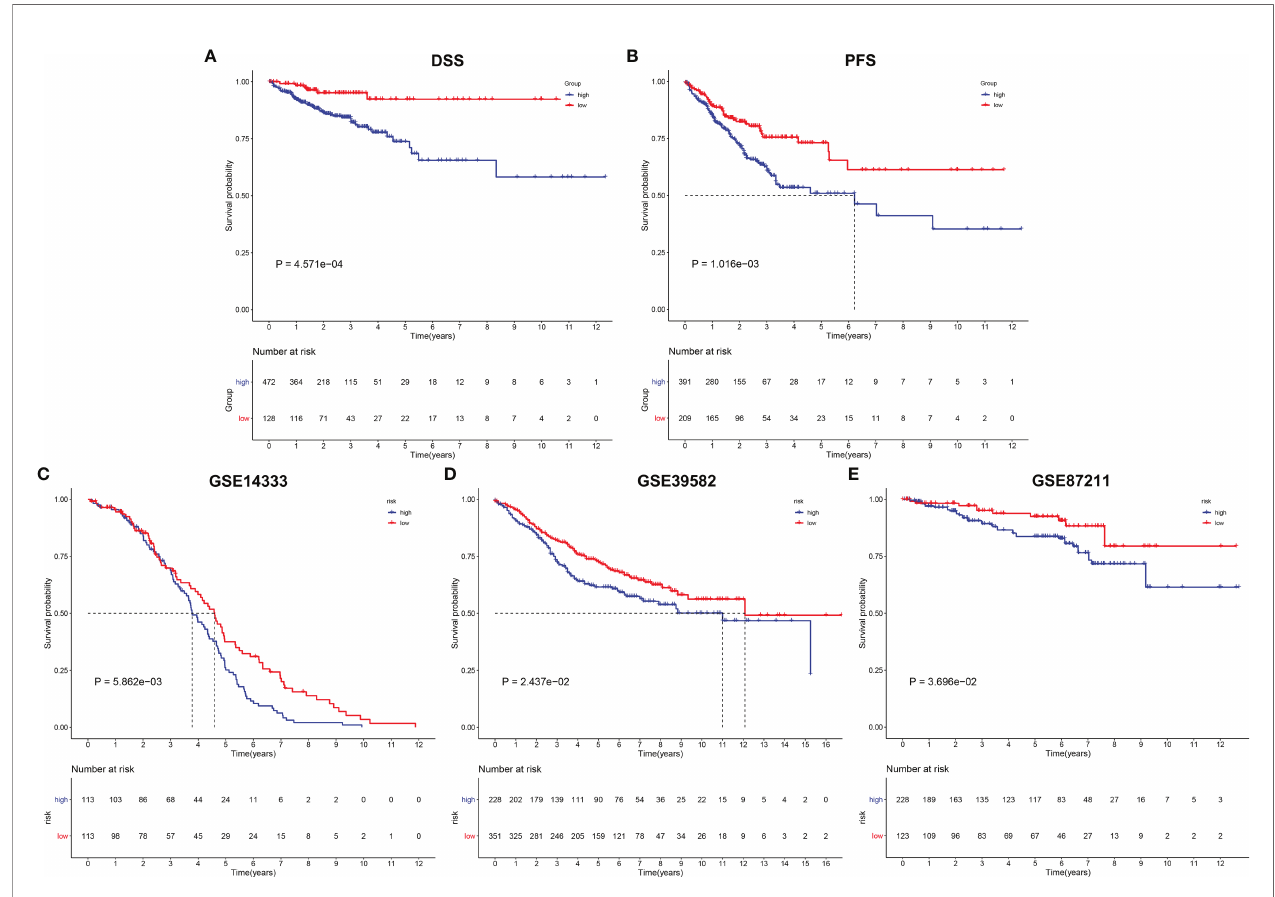
FIGURE 7 | Veri fi cation of prognostic signi fi cance of EVA1B-derived genomic model in CRC. (A, B) Kaplan – Meier curves of DSS and PFS for high and low CRC subpopulations in TCGA cohort. (C – E) Kaplan-Meier curves of OS for high and low CRC subpopulations in the (C) GSE14333, (D) GSE39582, and (E) GSE87211